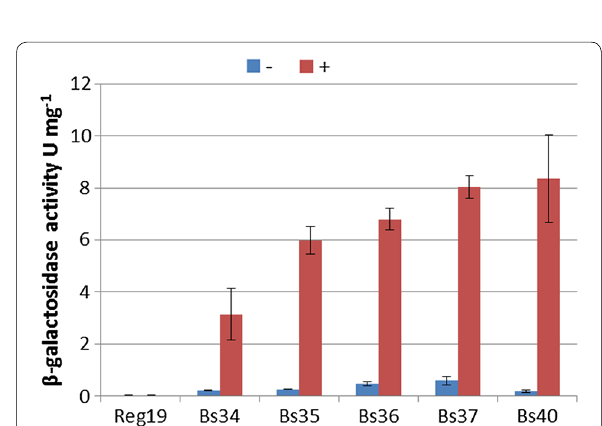
Fig. 3 GanA ß-galactosidase activity in cleared crude extracts from B. subtilis containing none (REG19), 1 copy (JA-Bs34), 2 copies (JA-Bs35), 3 copies (JA-Bs36), 4 copies (JA-Bs37) and 5 copies (JA-Bs40) of the P gut - ganA cassette. The cells were grown in LB with either 0.5% glucitol ( ) or 0.5% glucose ( ) and after 16 h crude cell + − extract was prepared for determining β-galactosidase activity and protein concentration. The values are the mean of three different